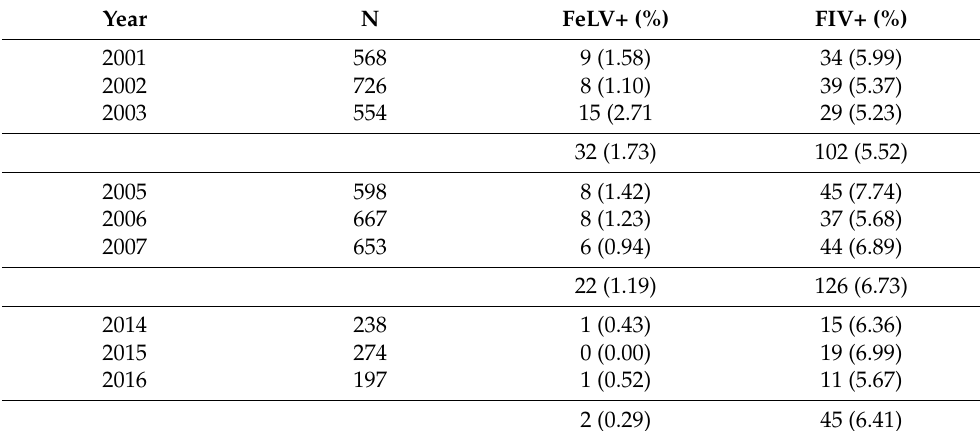
Table 2. Feline retroviral prevalence among feral cats presented to the PHS Spay/Neuter Clinic in